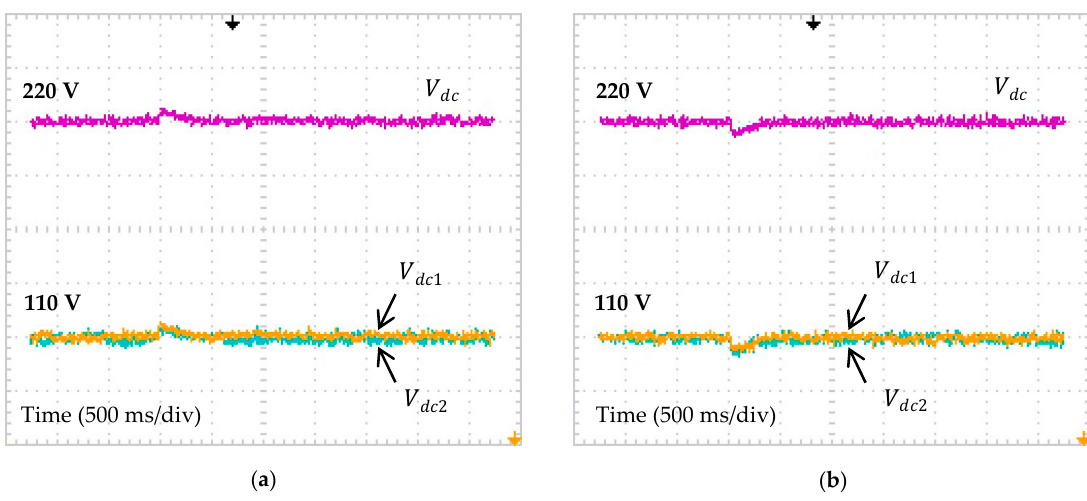
Figure 14. Experimental waveforms of overall DC-link voltage V dc (20 V/div) and splitting DC-link capacitor voltages V dc 1 (10 V/div) and V dc 2 (10 V/div) for dynamic-state conditions of ( a ) resistive to inductive and ( b ) inductive to resistive.